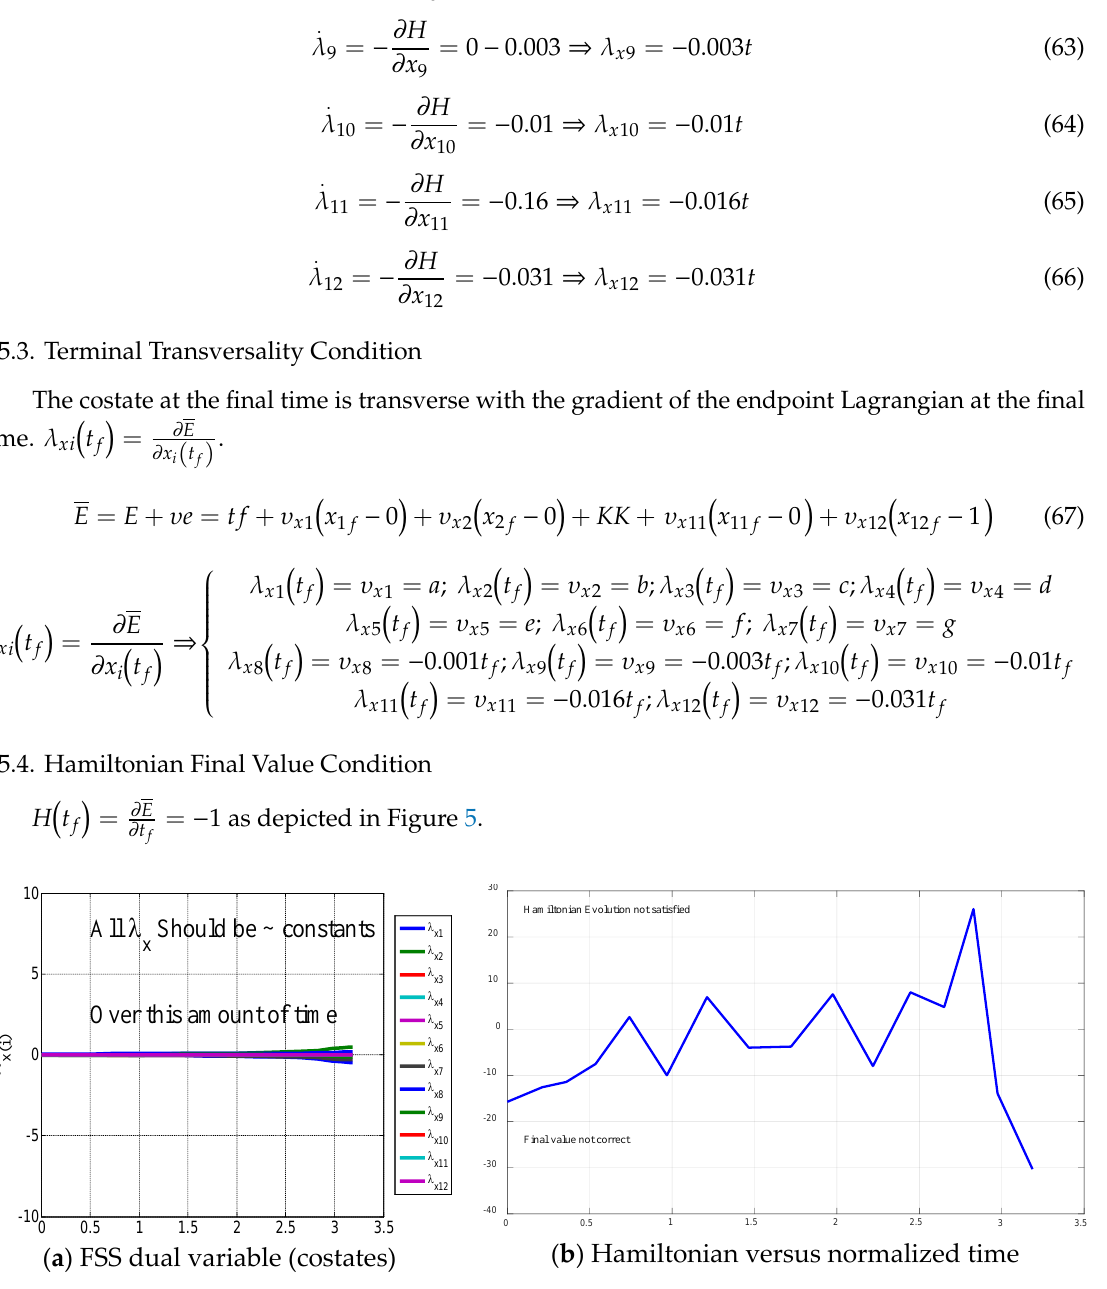
Figure 5. Scaled and unscaled plots of normalized costates and controls (calculated optimal cost = 3.1869) where normalized (scaled) time units are on the abscissa.